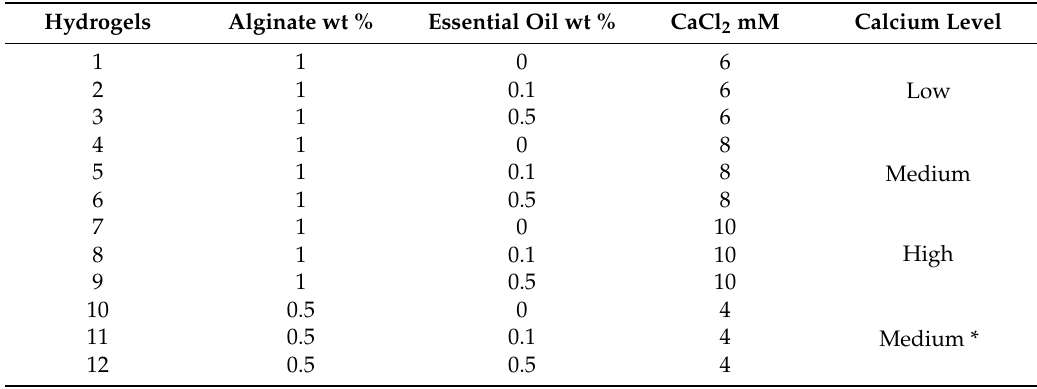
Table 1. Hydrogel compositions. Tween 80 concentration was kept constant at 1 wt %. * These samples were considered with a medium calcium level, because they have the same ratio of alginate/Ca 2+ as samples 4, 5, and